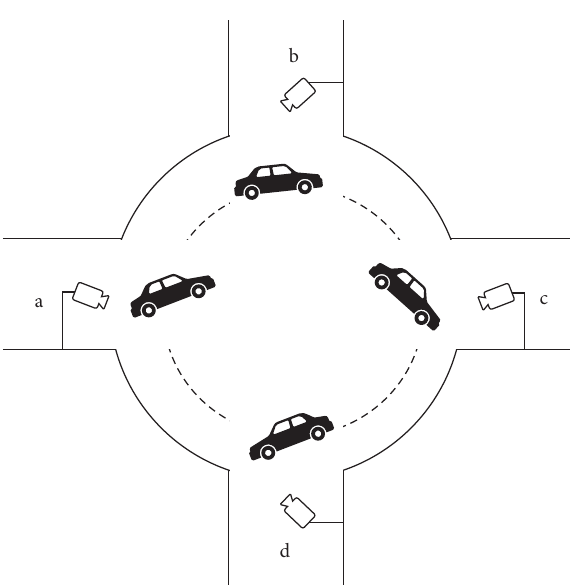
Figure 2: The installation location of 4 monitors.